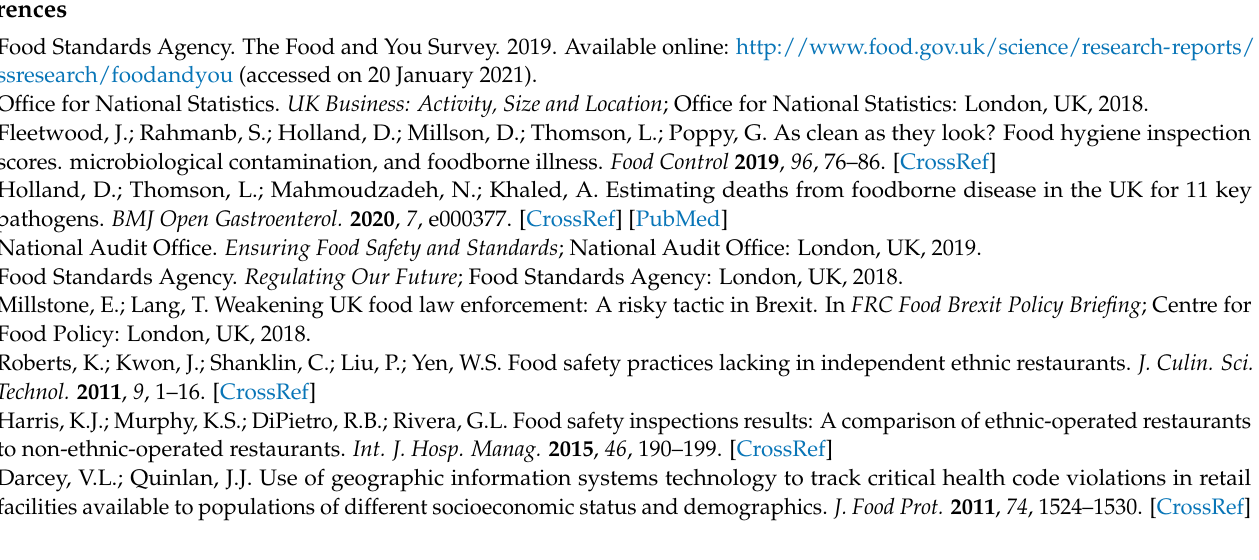
and Wales. Figure S2: Box and whisker plots are generated for the Kappa metric averaged for cross-validation iterations. The minimum, maximum, mean and interquartile range are calculated for each model. Where US = under-sampled datasets; SMOTE = Synthetic Minority Oversampling Technique datasets; Linear = Linear SVM; Radial = Radial SVM; RF = Random Forest. Suffixed numbers represent sampling ratios of non-compliant to compliant food outlets as follows: 1 = 1:1; 2 = 2:1; 3 = 3:2; 4 = 2:3; 5 = 1:2. Figure S3: Box and whisker plots are generated for the AUC metric averaged for cross-validation iterations. The minimum, maximum, mean and interquartile range are calculated for each model. Where US = under-sampled datasets; SMOTE = Synthetic Minority Oversampling Technique datasets; Linear = Linear SVM; Radial = Radial SVM; RF = Random Forest. Suffixed numbers represent sampling ratios of non-compliant to compliant food outlets as follows: 1 = 1:1; 2 = 2:1; 3 = 3:2; 4 = 2:3; 5 = 1:2. Figure S4: ROC curves and AUC values are generated for each model. Steep ROC curves and high AUC values indicate better performance than shallow ROC curves and low AUC values. SMOTE Radial 1 and under-sampled Radial 3 did not converge. Table S1: Sensitivity, specificity, precision, and kappa for all